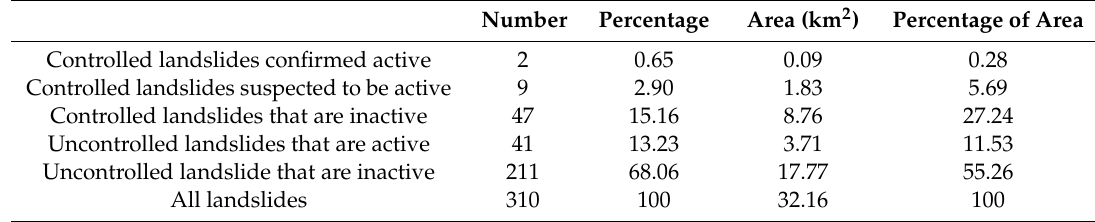
Table 2. Result of the deformation inspection based on the proposed